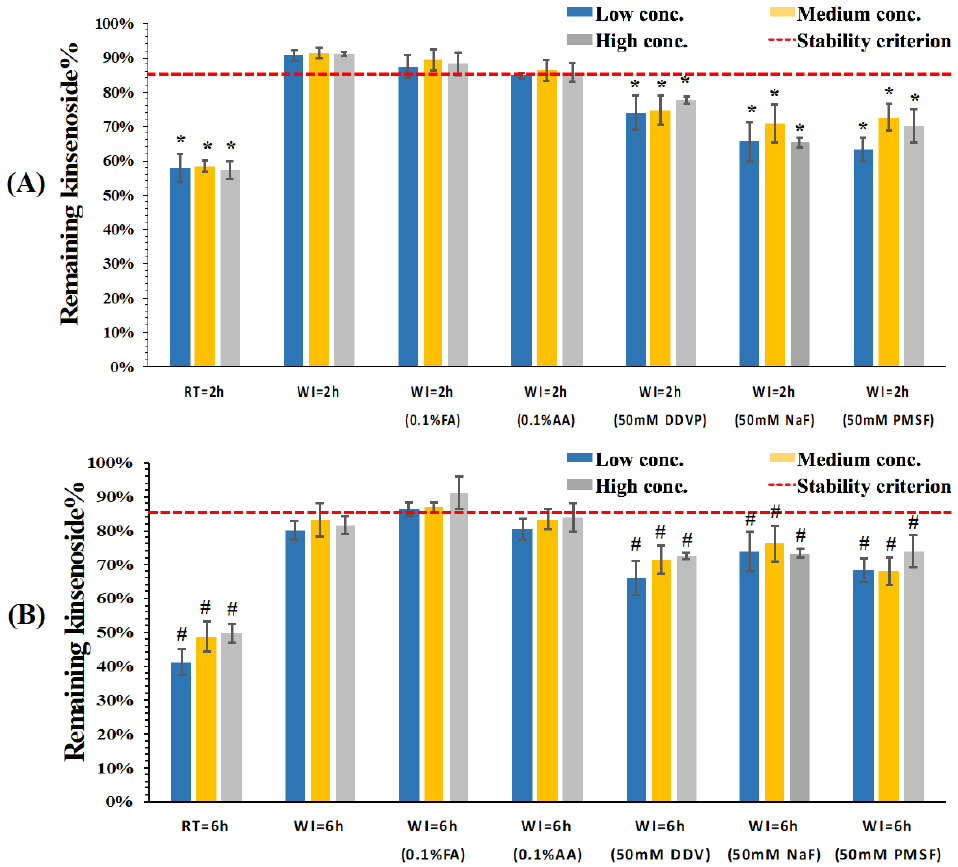
Figure 3. Remaining percentage of kinsenoside in beagle dog plasma after ( A ) 2 h and ( B ) 6 h incubation under room temperature and wet ice conditions ( n = 3). The red dash lines indicate the stability criterion (85% of the nominal analyte concentrations). FA: formic acid; AA: acetic acid; DDVP: 2,2-Dichlorovinyl dimethyl phosphate; NaF: sodium fluoride; PMSF: phenylmethanesulfonyl fluoride. * p < 0.05 compared with plasma samples incubated on wet ice after 2 h; # p < 0.05 compared with plasma samples incubated on wet ice after 6